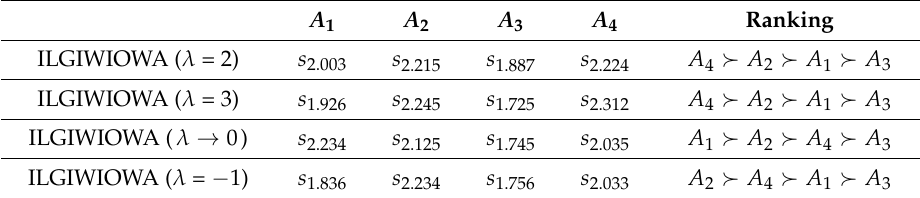
Table 2. Aggregated results by the intuitionistic linguistic generalized weighted induced ordered weighted averaging (ILGWIOWA) and the rankings of alternatives. A 1 A 2 A 3 A 4 Ranking ILGIWIOWA ( λ =